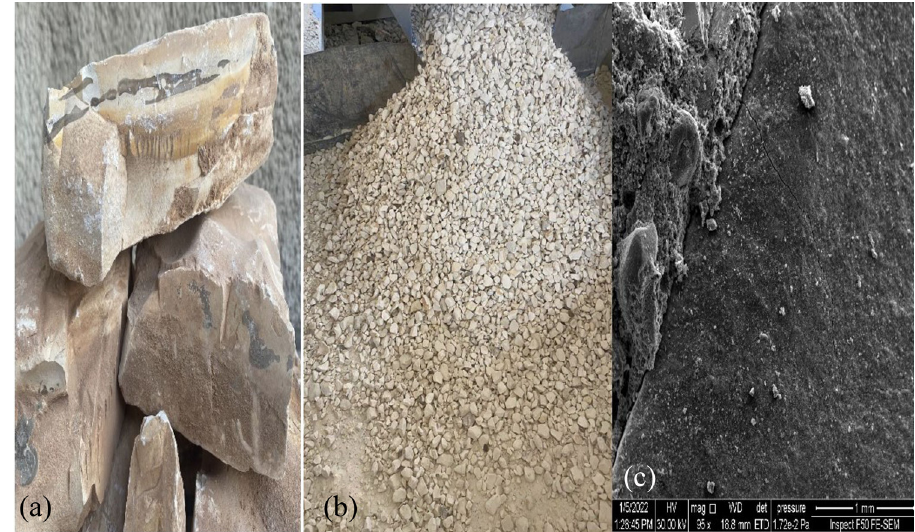
Figure 1: ( a ) Iraqi porcelanite rock, ( b ) porcelanite after mechanical crushing, and ( c ) porcelanite in concrete at